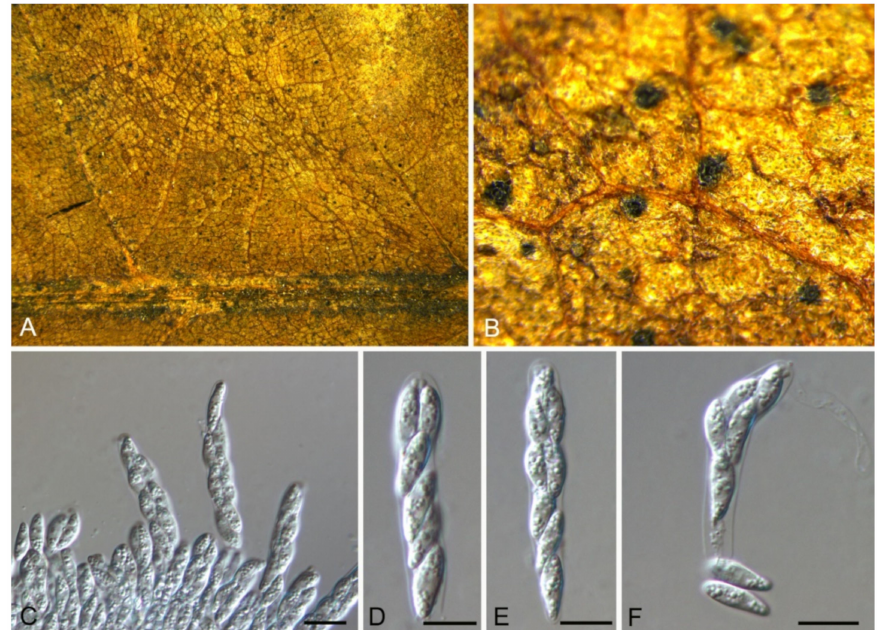
Figure 24. Pyrispora castaneae (BJFC-S1800). ( A , B ) Ascomata on the diseased leaves of Castanea mollissima ; ( C – F ) Asci and ascospores. Scale bars: ( C – F ) = 10 µ